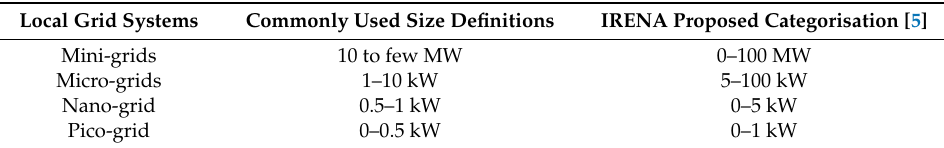
Table 1. Size ranges of local grid systems. Source: Compiled by